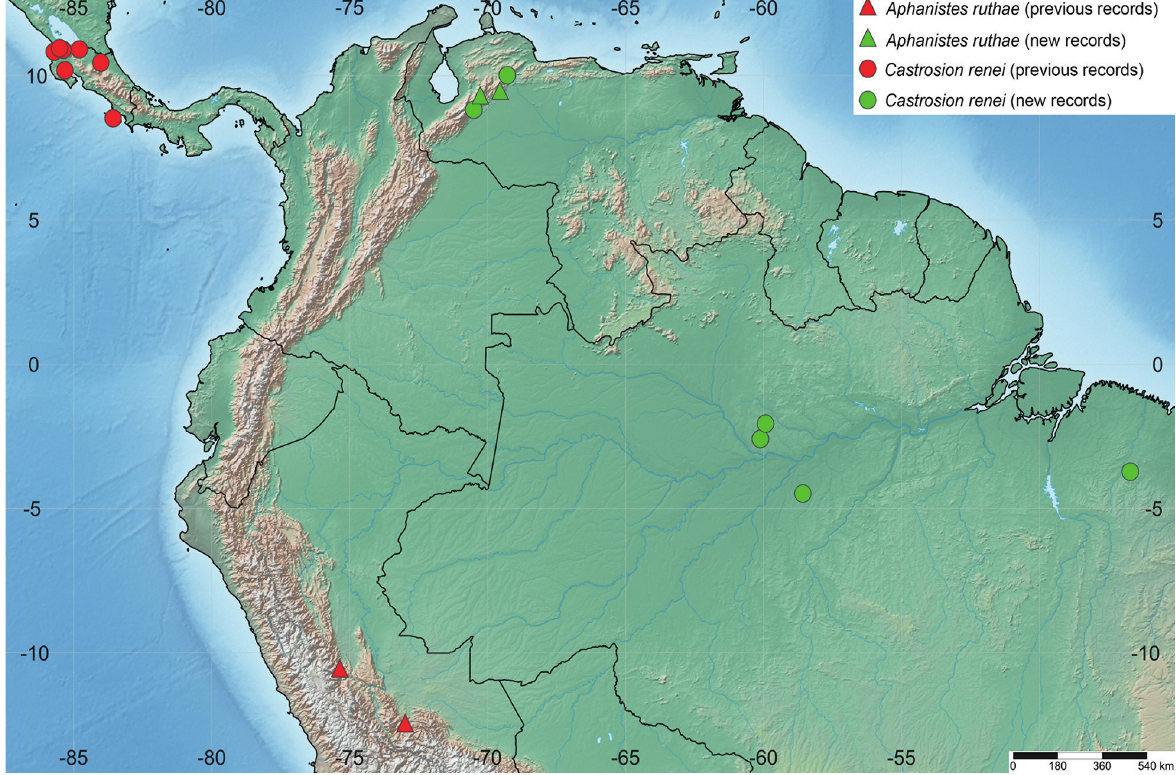
Figure 2 - Distribution records of Aphanistes ruthae Alvarado, 2018 and Castrosion renei gauld & Bradshaw, 1997.